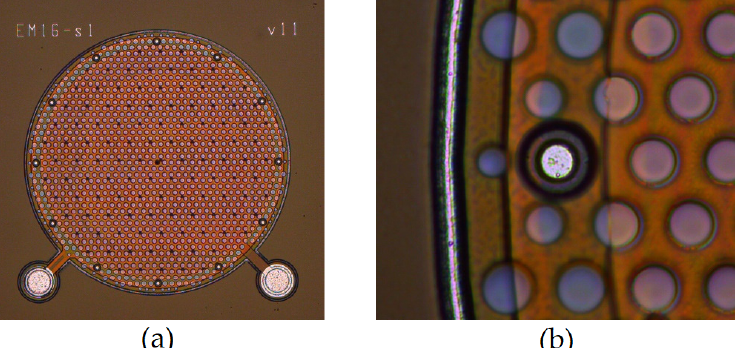
Figure 9. Microscope image of ( a ) the fabricated capacitive MEMS microphone in [11], with ( b ) an enlarged view of the dual-anchor